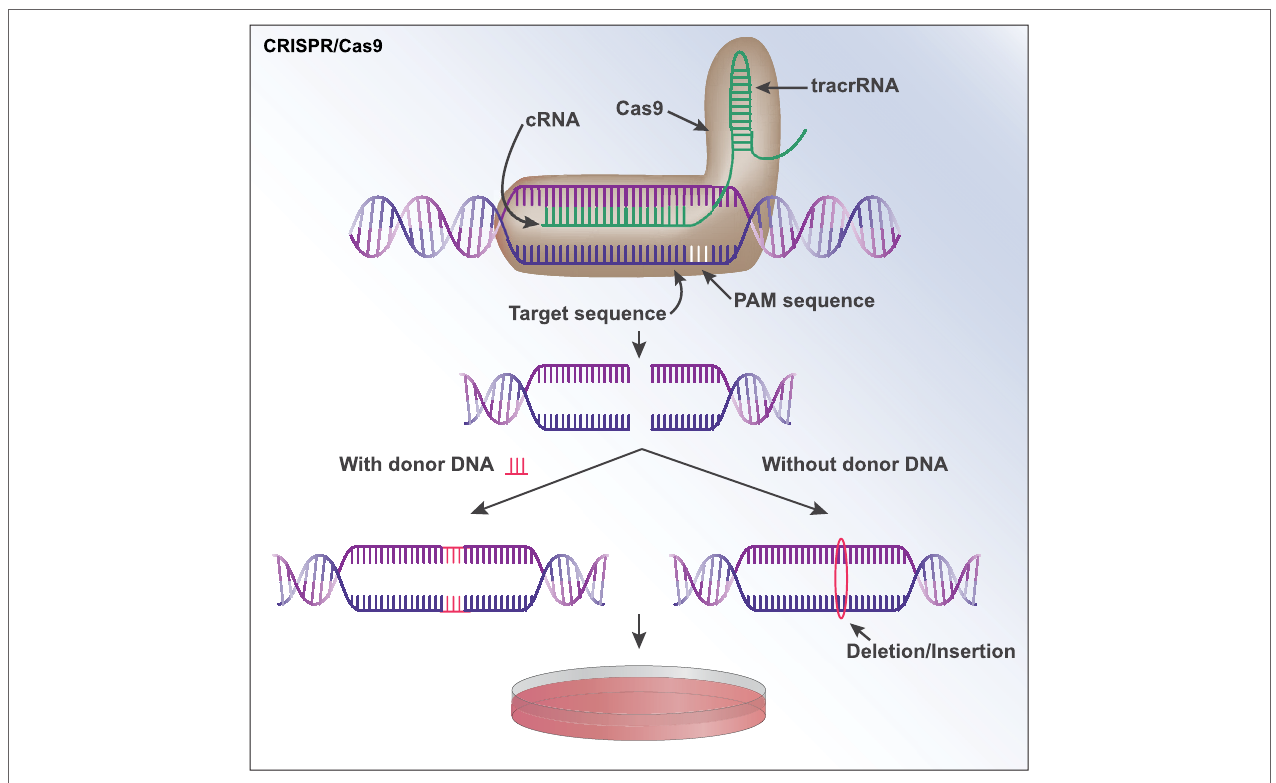
FigURe 3 | CRISPR/Cas9. A sequence of DNA can be modified by CRISPR/Cas9 through the formation of a guide RNA (gRNA) that contains an RNA complementary to the target DNA sequence. The gRNA additionally contains a noncoding transactivating RNA (tracrRNA) that functions as a “scaffold” to bind to Cas9. The gRNA and Cas9 form a complex and is brought to the target sequence, where Cas9 binds to a specific protospacer adjacent motif (58). Cas9 then cuts both strands of the DNA. If the user supplies a “donor sequence,” it will serve as a repair template and be incorporated at the break site in a process known as homology-directed repair. If no donor sequence is provided, indels are often created as the cell repairs the double-strand break via non-homologous end joining. This can knock out the gene of interest, as the indels are often capable of creating frameshift mutations. The modified sequence can now be expanded in cells in